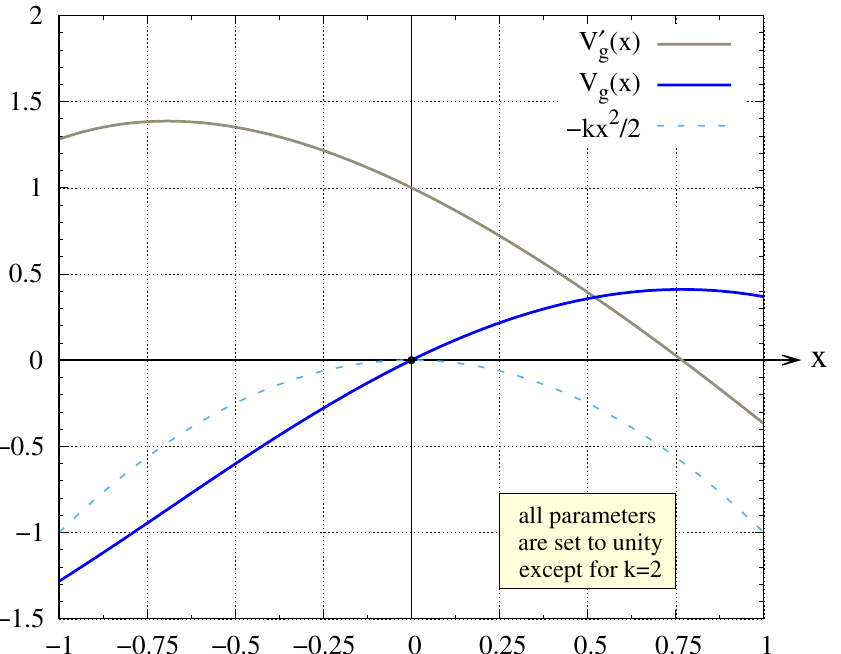
Figure 2. The relativistic gravitational potential, V g ( x ) , for an oscillating body posted in a strong uniform gravitational field. For the graphical representation we use m 0 = 1kg, g = 1kgm/s 2 , and k = 2kg/s 2 . Further, the speed of light is normalized to c = 1m/s. The dashed line marks below the physically allowed region for V g , viz. Equation (20). The gradient, V (cid:48) g ( x ) , is also